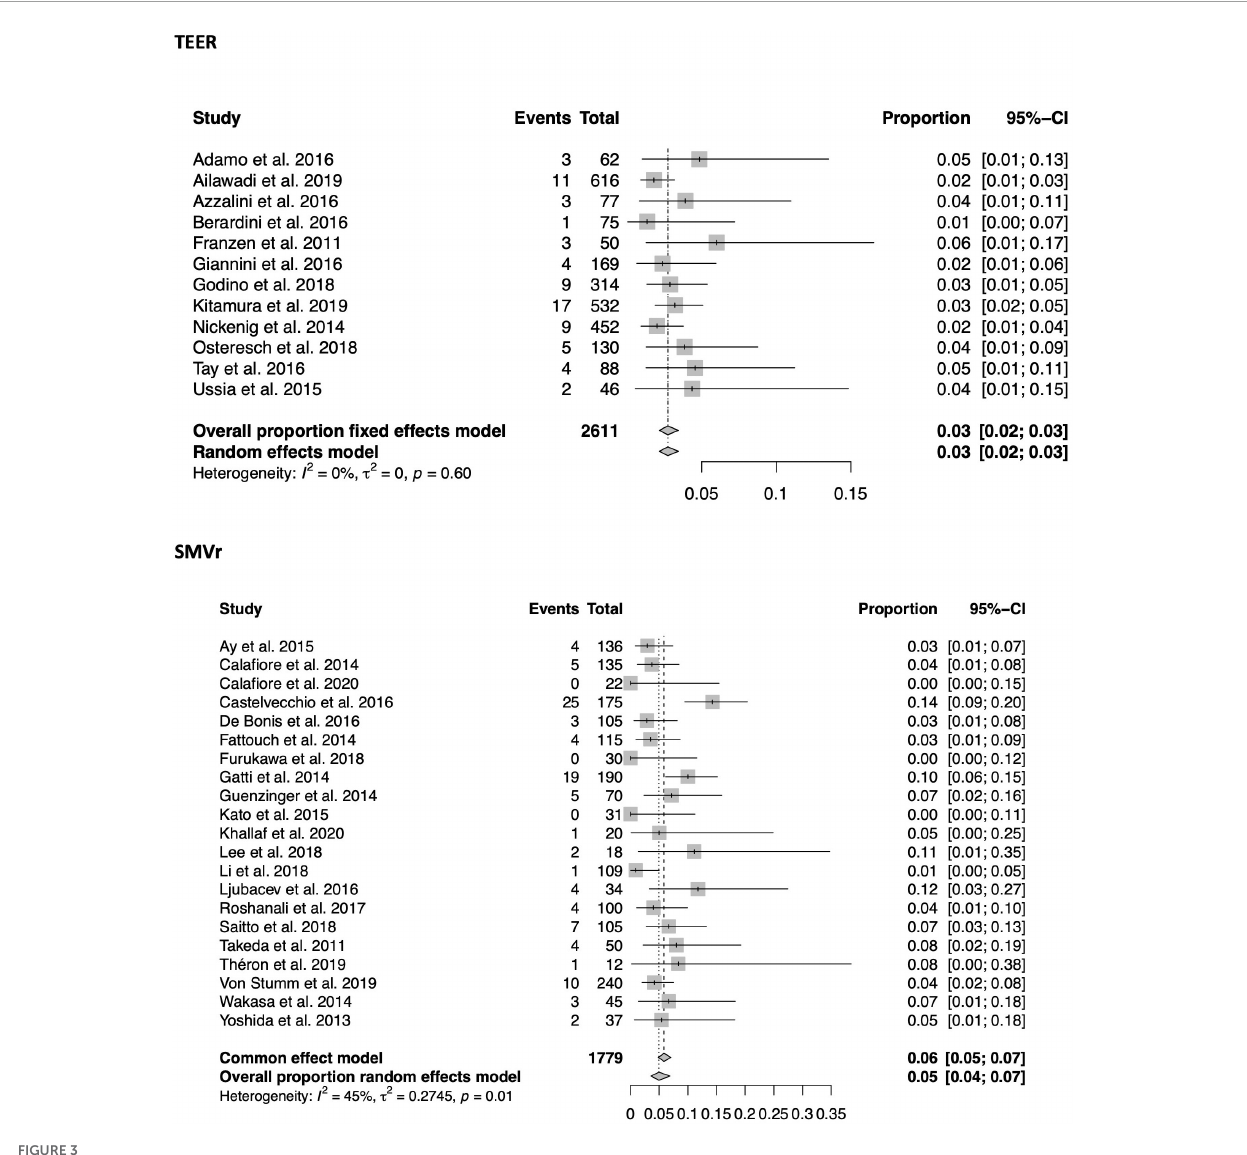
FIGURE3 Forrest plots of the comparison between TEER and SMVr for in-hospital mortality. TEER, transcatheter edge-to-edge repair; SMVr, surgical mitral valve